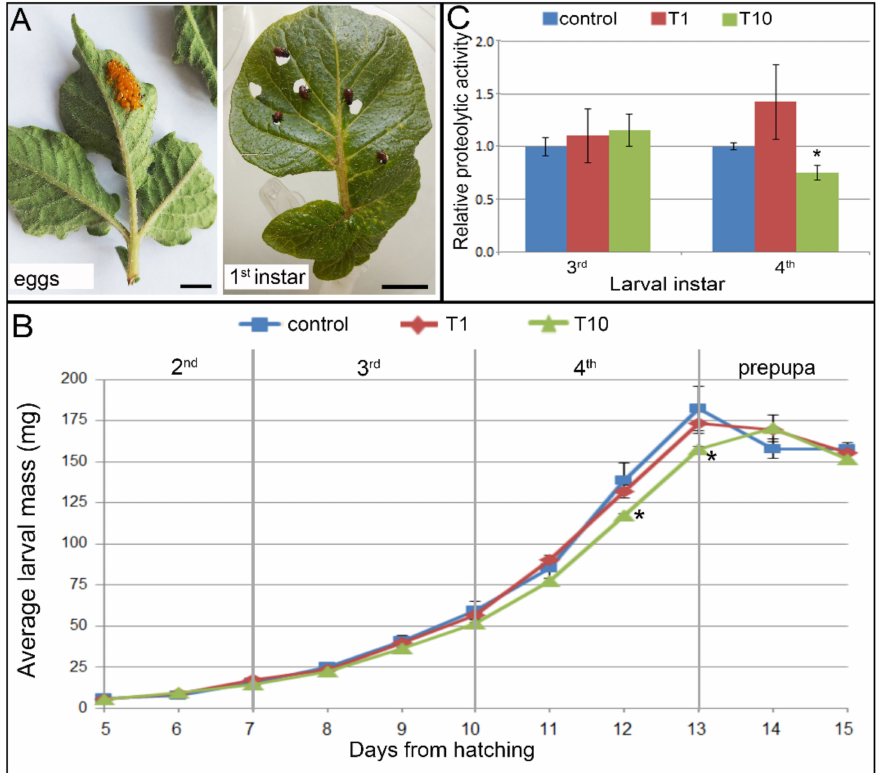
Figure 3. Effect of French marigold methanol extract of flowers on CPB larval growth and digestive activity. Larvae of 2nd instar hatched from eggs ( A ) were fed with potato leaves coated with the extract in concentrations 1 mg/mL (T1) or 10 mg/mL (T10) or with control leaves. Larval mass gain ( B ) was recorded daily during the entire larval development, from the 2nd through 4th instar to the prepupal stage (given stage borders are for controls). Digestive protease activity ( C ) in midguts of 3rd and 4th instars fed with T1 and T10 coated potato leaves was analyzed and presented relative to activity measured in control larvae fed with non-coated leaves. All results are presented as means ± standard errors ( n = 15 for ( B ) and n = 3 for ( C )), and values with an asterisk (*) were different than corresponding controls according to Student’s t -test ( p ≤ 0.1) for each day of measurement (for ( B )) or larval stage (for ( C )) separately. Bars represent 1